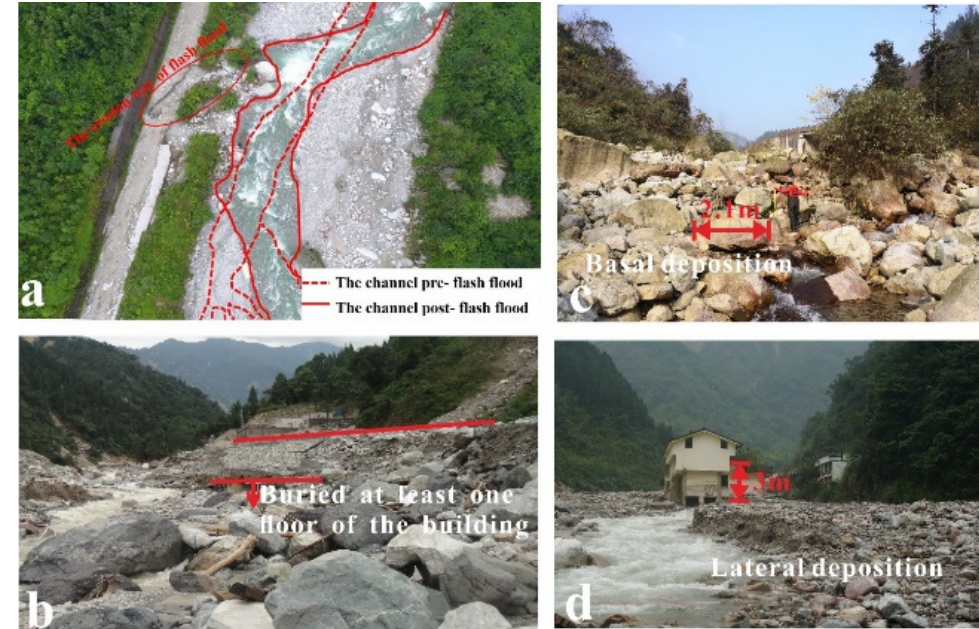
Figure 6. Morphological change and characteristics of the unconfined channel: ( a ). Extension of the channel in the unconfined channel part occurred by 4 July 2018; ( b ) Elevation of the channel bed in the unconfined channel occured by 22 August 2010; ( c ) Basal deposition occurred by 4 July 2018, ( d ). Lateral deposition occurred by 4 July 2018.